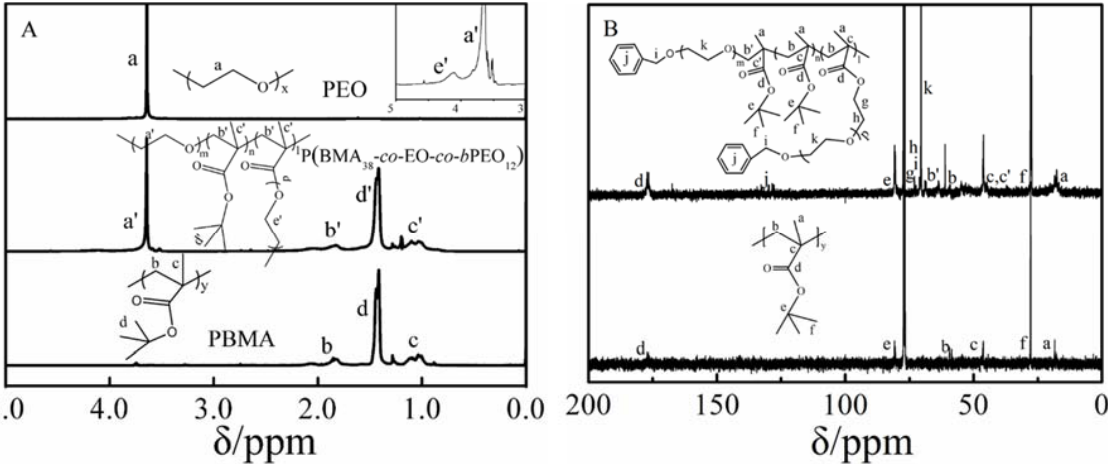
Figure 1. ( A ) 1 H NMR spectra of PEO, PBMA and their copolymers, ( B ) 13 C NMR spectra of PBMA and P(BMA 38 - co -EO- co - b PEO 12 ). Table 1. Characterization data of BMA and EO (co)polymerization product a .